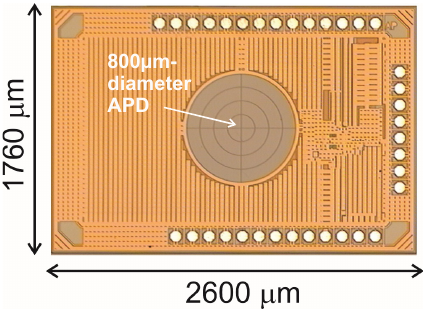
Figure 2. ( a ) Block diagram of APD receiver and ( b ) circuit diagram of TIA.